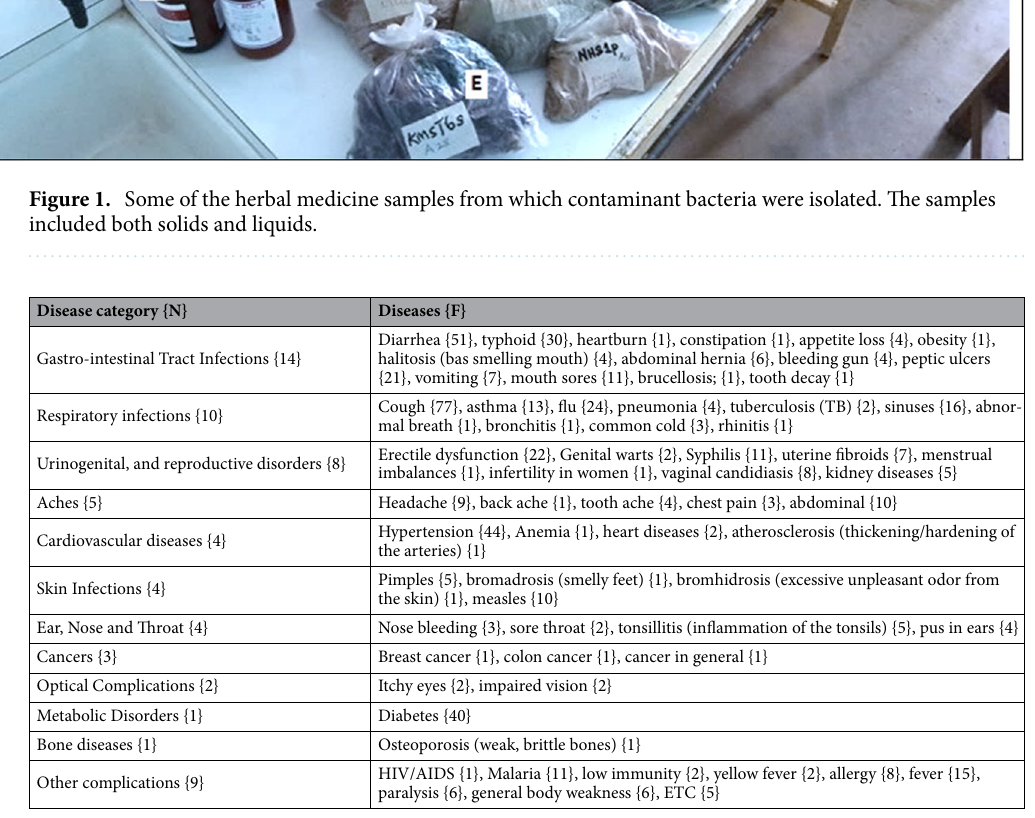
Table 2. Ailments that were suggested to be treated by the herbal medicines from which bacterial contaminants were isolated in this study. N number of diseases in a disease category, F frequency, HIV/ AIDS human immunodeficiency virus/acquired immunodeficiency syndrome, ETC Et cetera/and the rest (unspecified diseases).